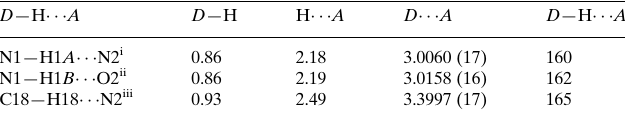
Hydrogen-bond geometry (A˚ , (cid:2)